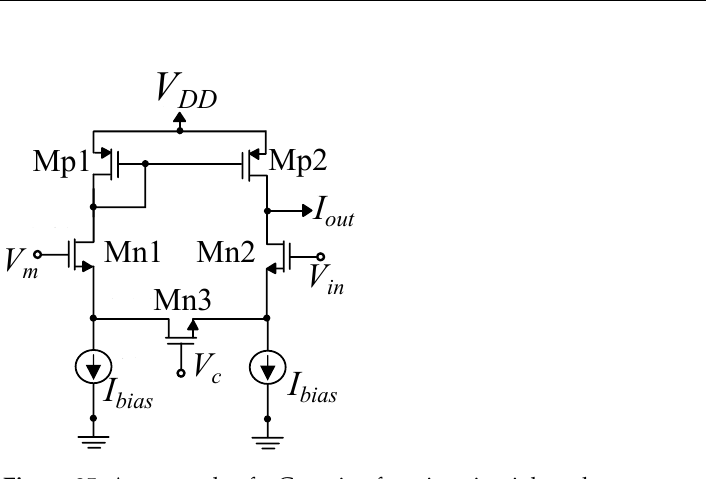
Figure 35. An example of a Gaussian function circuit based on an exponentiator circuit.